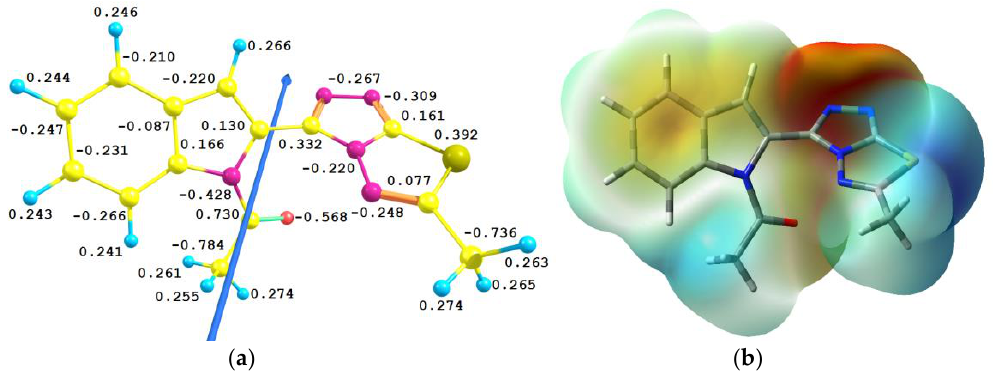
Figure 10. The natural charges over the optimized structure with dipole moment vector ( a ) and MEP map ( b ).